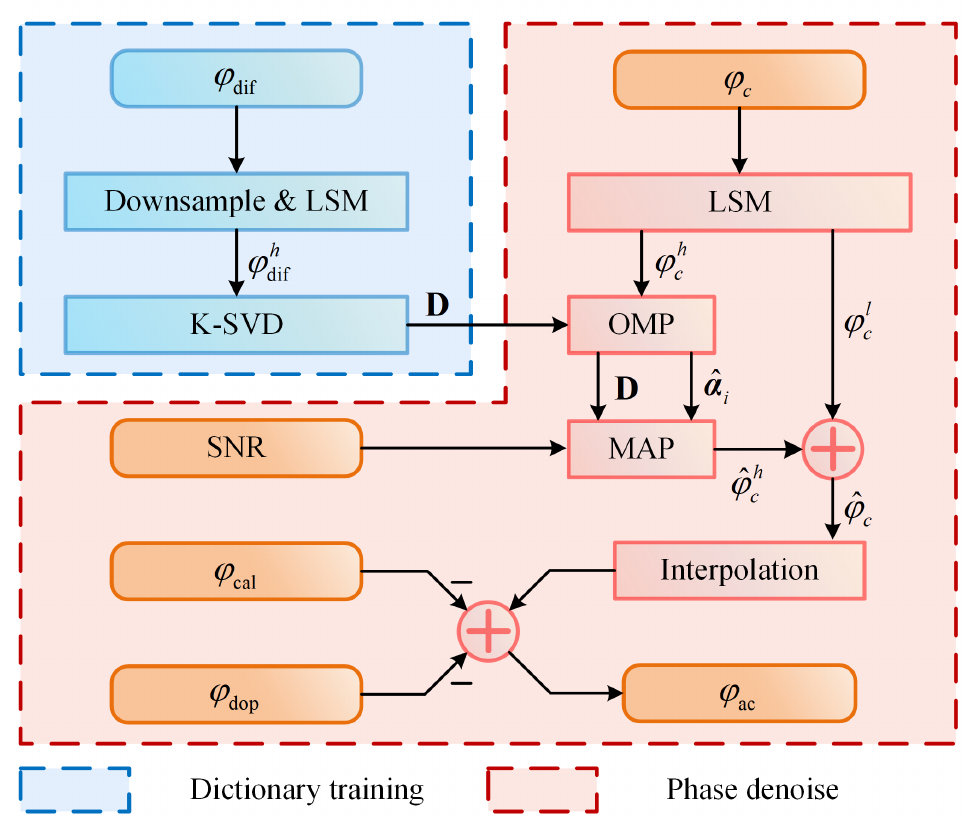
Figure 4. Flowchart of the proposed algorithm.